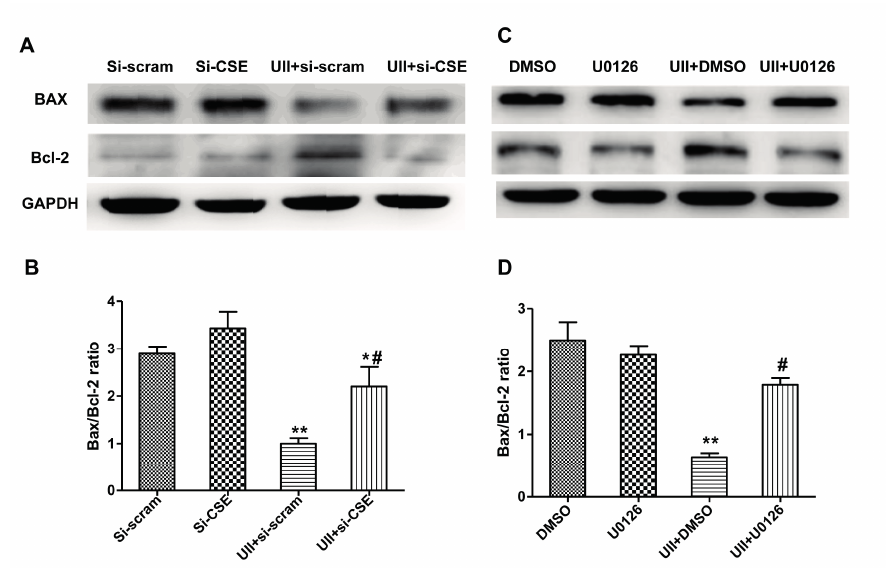
Figure 5. Si-CSE or ERK inhibitor partly abolishes the downregulation of Bax/Bcl-2 induced by UII on H 2 O 2 -treated-cardiomyocytes. Representative image of Bax and Bcl-2 ( A ) and quantitative analysis of Bax/Bcl-2 ( B ) by Western blot analysis in cultured cardiomyocytes transfected with si-scramble or si-CSE for 48 h, treated with UII or PBS for 30 min, then exposed to 100 μ M H 2 O 2 for 24 h. Values are mean ± SEM. * p < 0.05, ** p < 0.01, UII + si-scram vs. Si-scram or UII + si-CSE vs. Si-CSE. # p < 0.05 UII + si-CSE vs. UII + si-scram. Representative image of Bax and Bcl-2 ( C ) and quantitative analysis of Bax/Bcl-2 ( D ) by Western blot analysis in cultured cardiomyocytes treated with DMSO or U0126 with or without UII for 30 min and exposed to 100 μ M H 2 O 2 for 24 h. Values are mean ± SEM. ** p < 0.01, UII + DMSO vs. DMSO or UII + U0126 vs. UII + DMSO. # p < 0.05, UII + U0126 vs. UII + DMSO. All experiments were repeated independently at least three